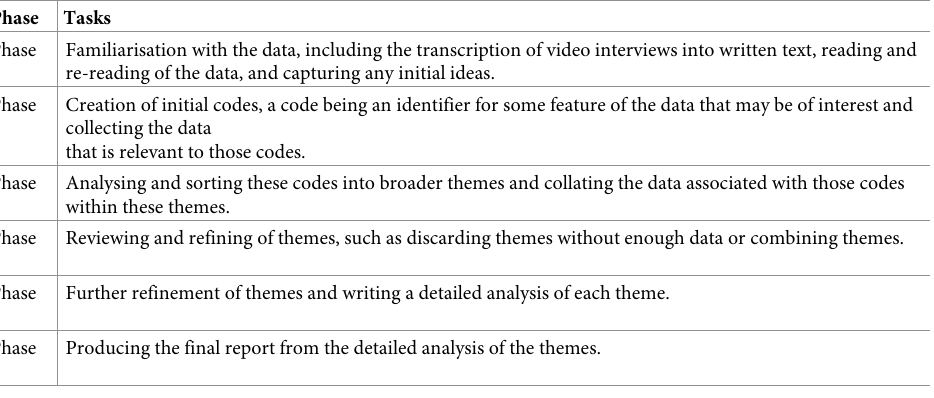
Table 1. Thematic analysis process, adapted from Braun and Clarke